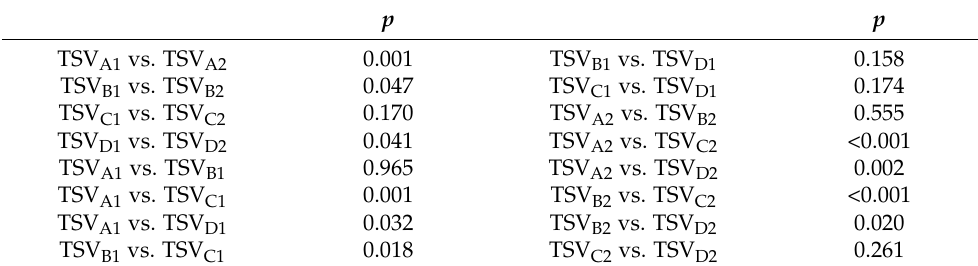
Table 5. Differences of TSV in different